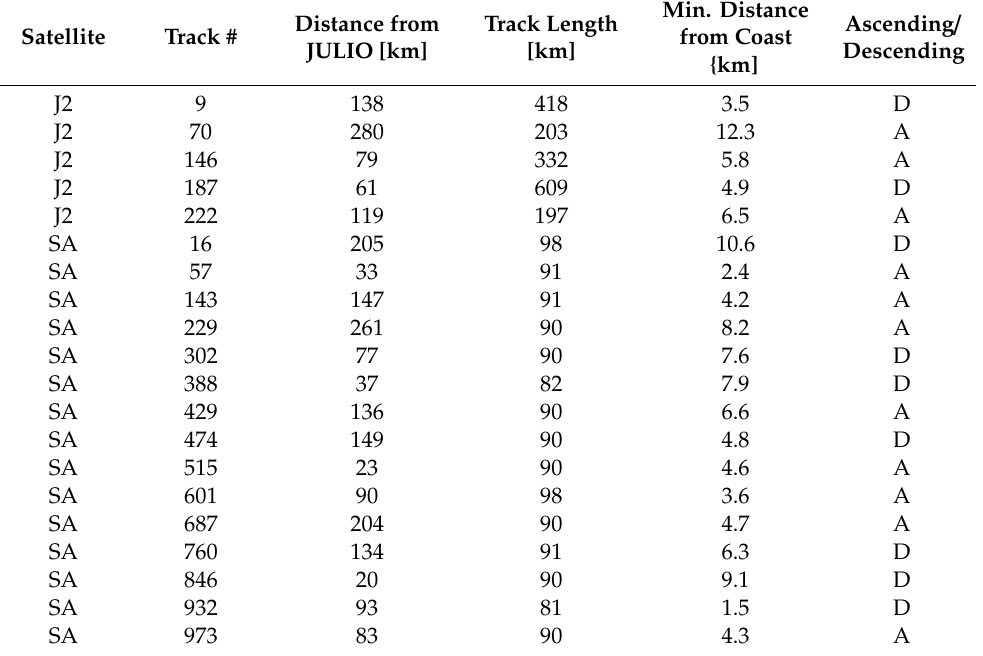
Table 1. List of the chosen altimeter tracks. For each track the satellite identifier, the track number, theminimumdistancefromJULIO,thelengthofthetracksegmentusedinthisstudy, theminimumdistance of the track from the northern Mediterranean Coast and the orientation of the track (A for Ascending, D for Descending) are